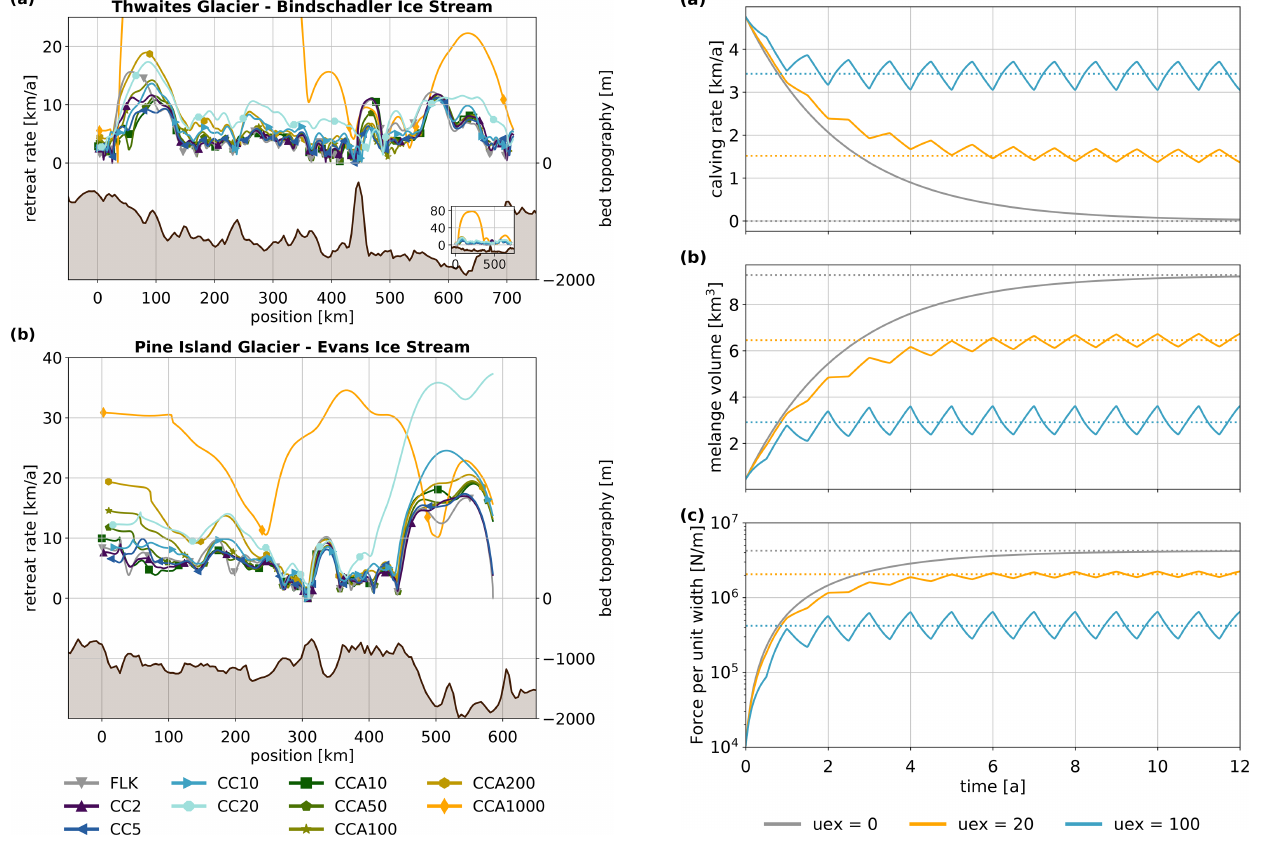
Figure 9. Grounding-line retreat rates along the flowlines in Thwaites (a) and Pine Island Glaciers (b) as a function of grounding-line position, together with bed topography. Markers are set every 10a.